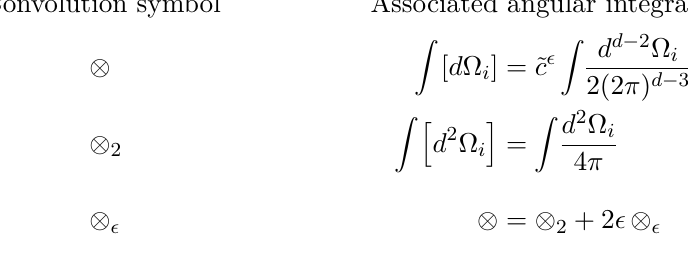
Table 1 . Angular convolution symbols and associated angular integrals for the individual partons i = 1 . . . m . In the final result, the factors ˜ c = e γ E /π cancel against the ones in the energy integrals in (2.5). We will use the same notation also for the integrations over additional partons indicated by ˆ ⊗